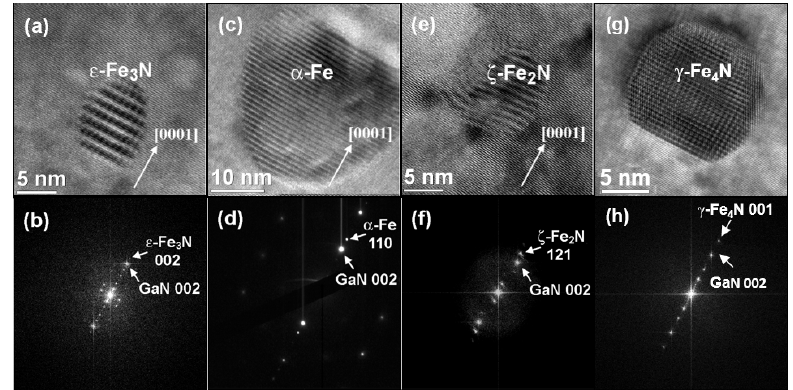
Figure 7. Embedded Fe y N nanocrystals with y = 0,1,2,3,4 in MOVPE grown Ga 1 − x Fe x N imaged by HRTEM and the corresponding fast-Fourier transformation images: ( a , b ) ε -Fe 3 N, ( c , d ) α -Fe, ( e , f ) ζ -Fe 2 N, and ( g , h ) γ ’-Fe 4 N. Adapted from Reference